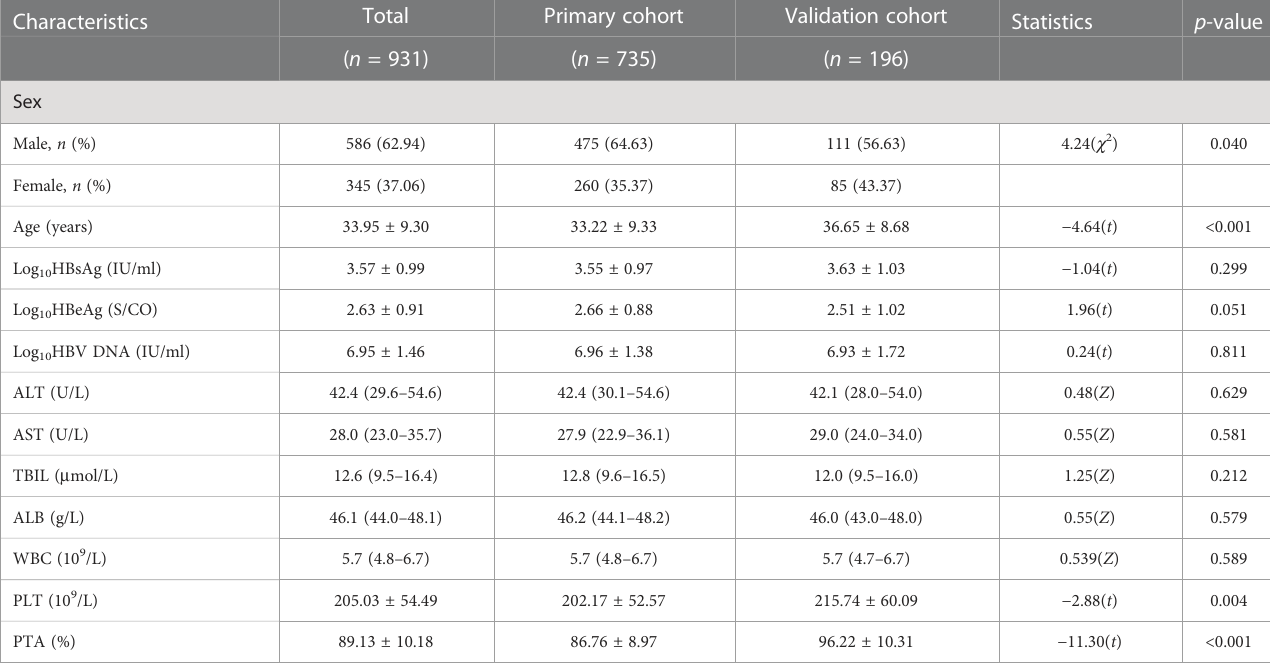
TABLE 1 Characteristics of the HBeAg-positive chronic hepatitis B (CHB) patients with ALT < 80 U/L in the primary and external validation cohorts.